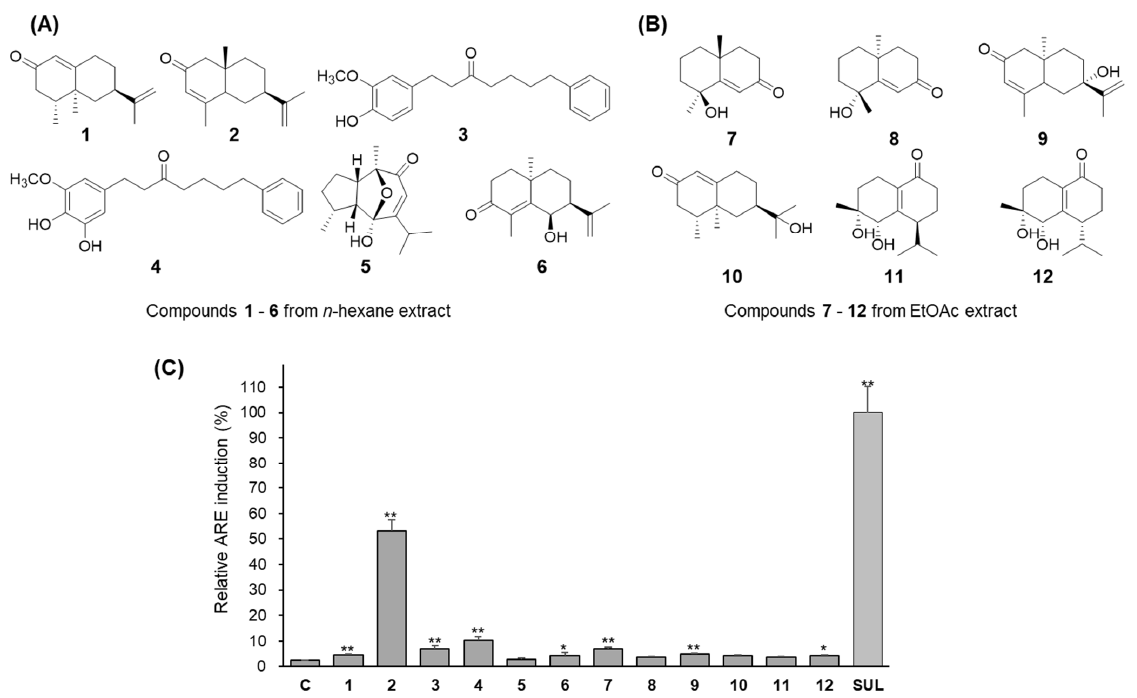
Figure 4. Chemical structures of isolated compounds 1 – 12 and their ARE-luciferase induction activity in HepG2 cells. ( A ) Compounds 1 – 6 were isolated from n -hexane extract. ( B ) Compounds 7 – 12 were purified from EtOAc extract. ( C ) The relative ARE induction activity of each compound to 5 μ M sulforaphane (%). Each compound was treated at a concentration of 30 μ M. Data are presented as the mean ± S.D. ( n = 3). * p < 0.05, ** p < 0.01 (compared with the vehicle-treated control). Sulforaphane (SUL) was treated as a positive control.